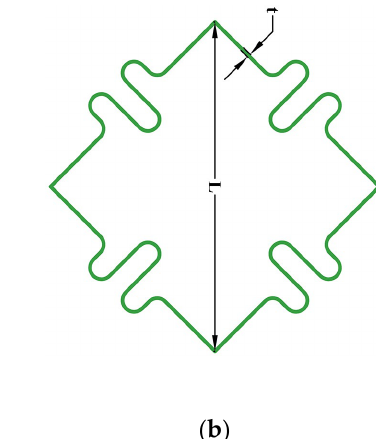
Figure 9. Schematic diagram of different geometric parameters of the S-shaped bulge of the facet element of the compliant cell: ( a ) different widths of the S-shaped bulge; ( b ) schematic of the beam section size of the compliant cell.